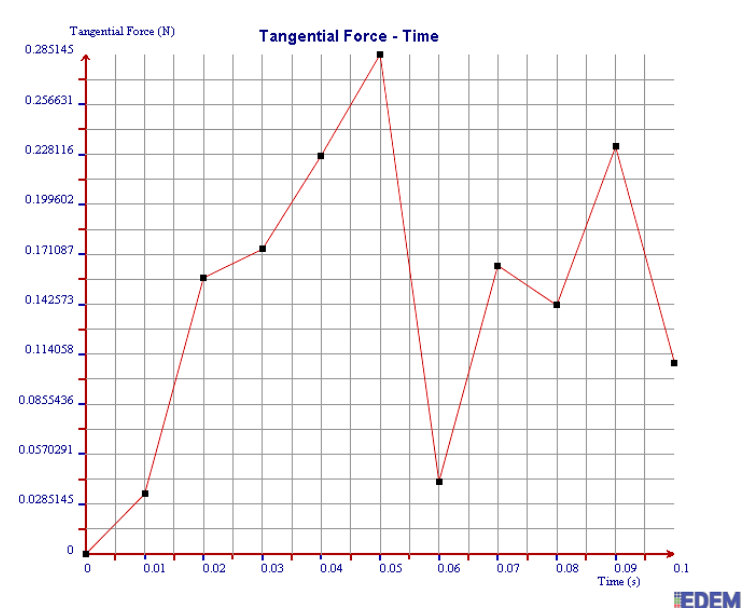
Figure. 17 Tangential force of 3 mm steel balls. Figure 17. Tangential force of 3 mm steel balls.